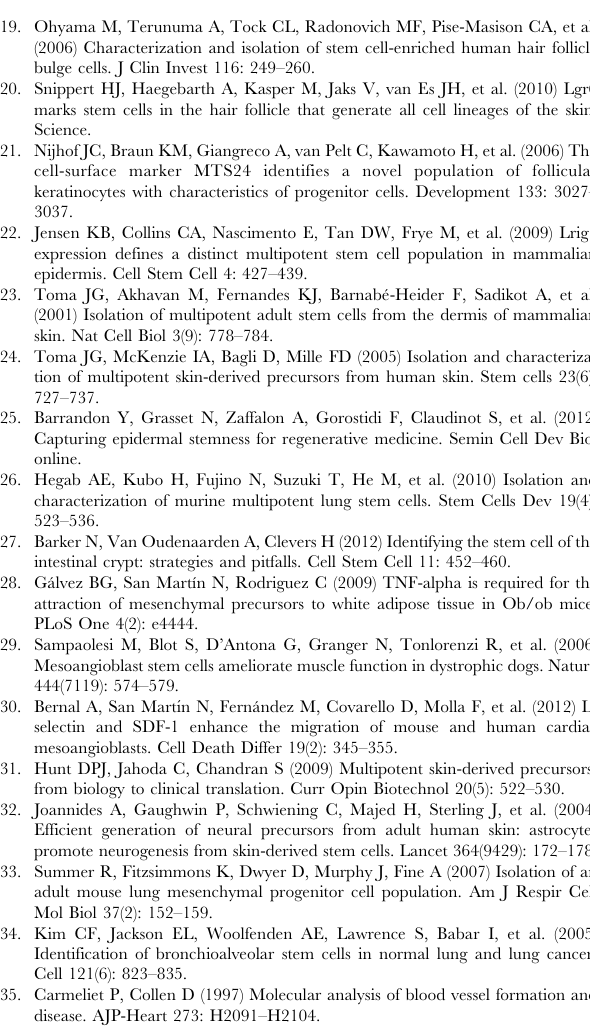
Figure S1 Differentiation properties of MPCs.